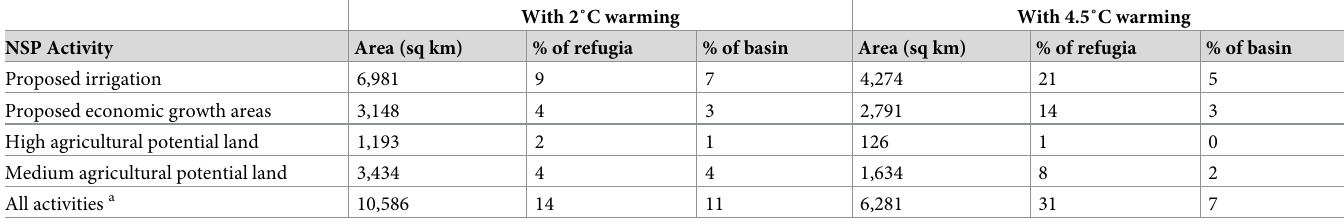
Table 1. Projected refugia at risk from National Spatial Plan